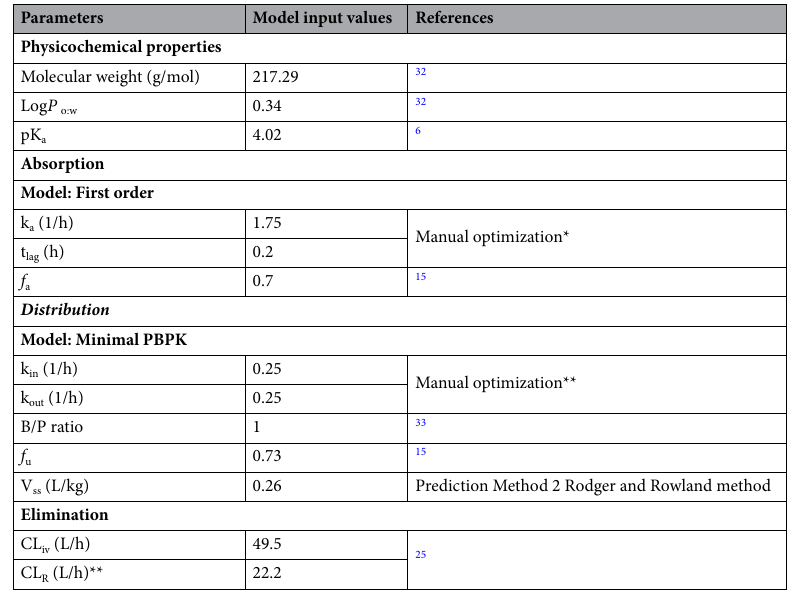
Table 1. Drug-specific model input parameters used for the development of the captopril PBPK model. LogPo:w; octanol–water partition coefficient, ADAM; advanced dissolution, absorption, and metabolism, P eff ; human jejunum permeability, f u ; fraction of unbound drug in plasma, V ss ; volume of distribution at steady- state, CL iv ; intravenous clearance, CL R ; renal clearance; k a ; first order absorption rate constant, f a ; fraction of absorbed drug, t lag ; lag time. *Manually adjusted after comparing reported and predicted data. **For details see Supplementary